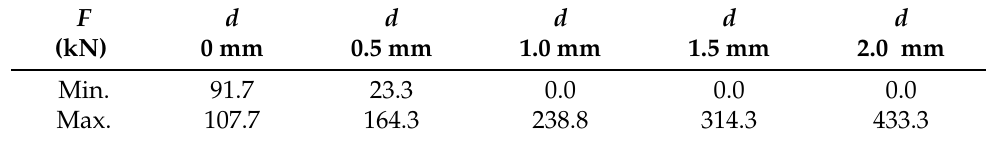
Min., minimum value; Max., maximum value; d , wheel flat